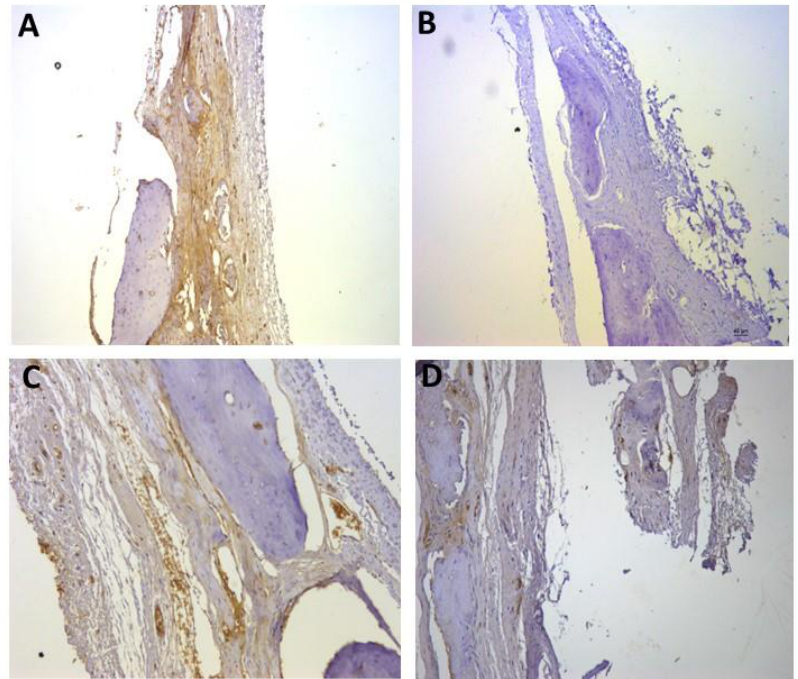
Figure 8. Representative immunohistochemistry images for osteocalcin staining. ( A ) control group; ( B ) negative control; ( C ) group 2 with marking considered (+); ( D ) group 8 with marking considered (+++); the most observed staining pattern among the groups analyzed. Harris ’ hematoxylin counterstained. Scale bar: 46 µm.